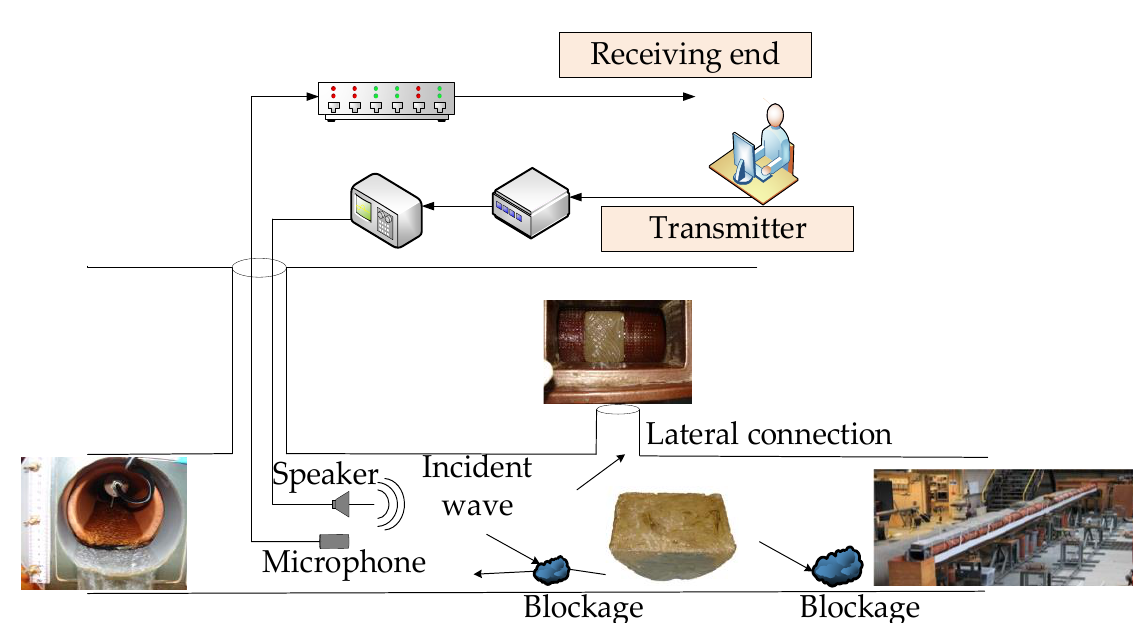
Figure 2. Experimental platform for pipe blockage detection.